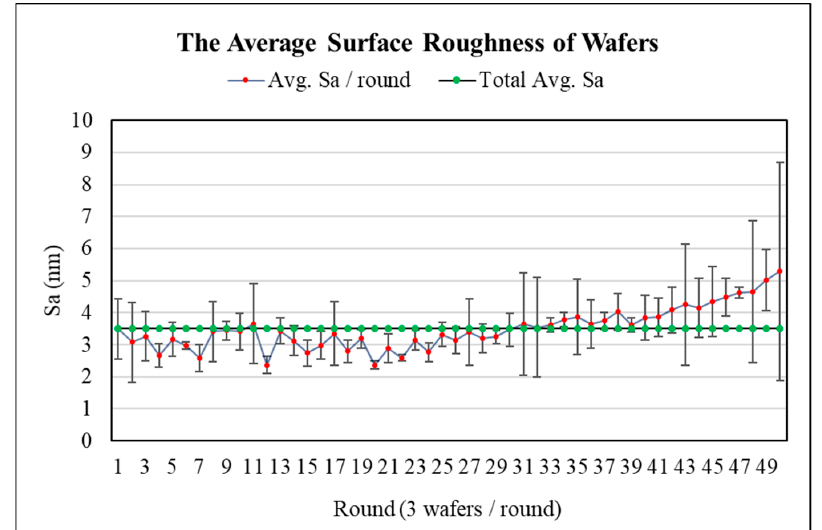
Figure 13. Average Sa of CuB wafer of 50 rounds of test.